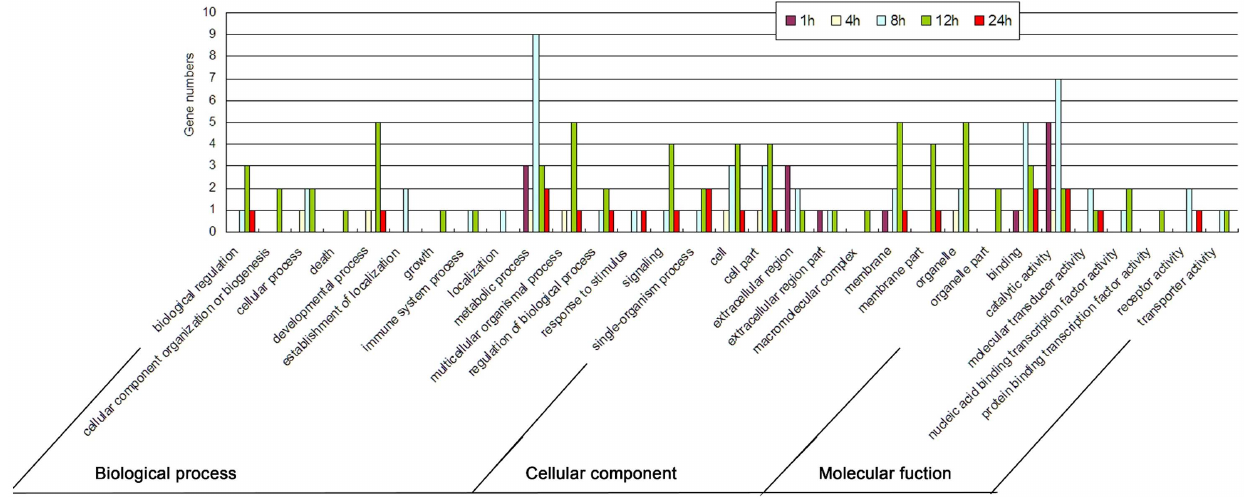
Figure 3. Summarizing of Gene Ontology functional classification of ten DGEs by comparing DA-treated and un-treated samples in differential time intervals, which described gene products in terms of their associated biological processes, cellular components and molecular functions.